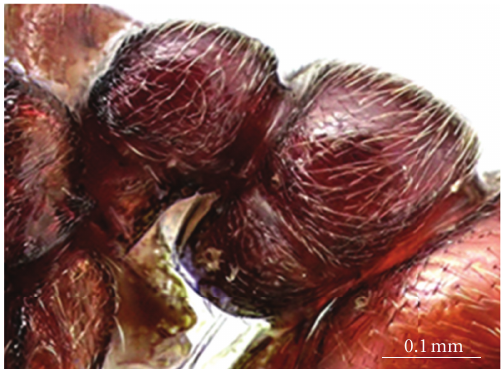
Figure 5: Tatuidris kapasi , holotype worker. Detail of petiole and postpetiole, left lateral view.